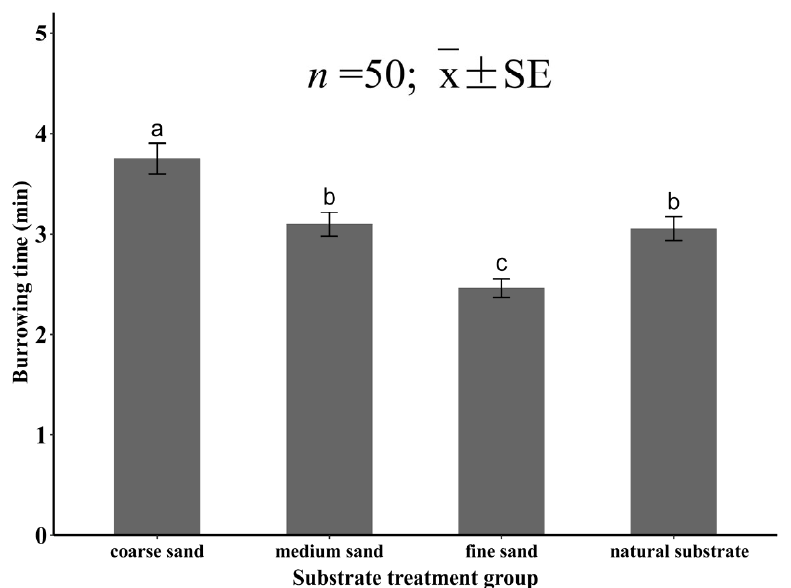
Figure 5. The burrowing time of juvenile Meretrix meretrix in different grain size substrates. The different letters above the bar graphs indicate significant differences ( p < 0.05).